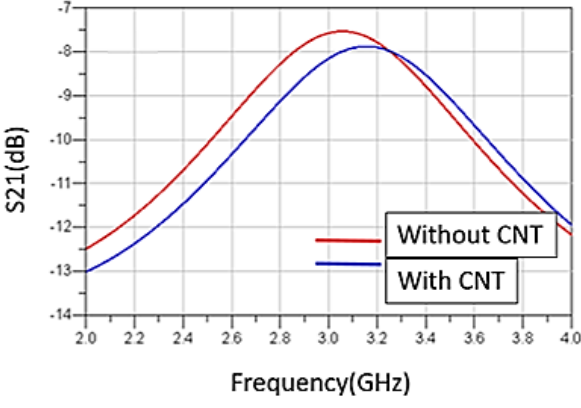
Figure 10. Measurements of the first mode without PEDOT: PSS-MWCNTs (red) and with it (blue).